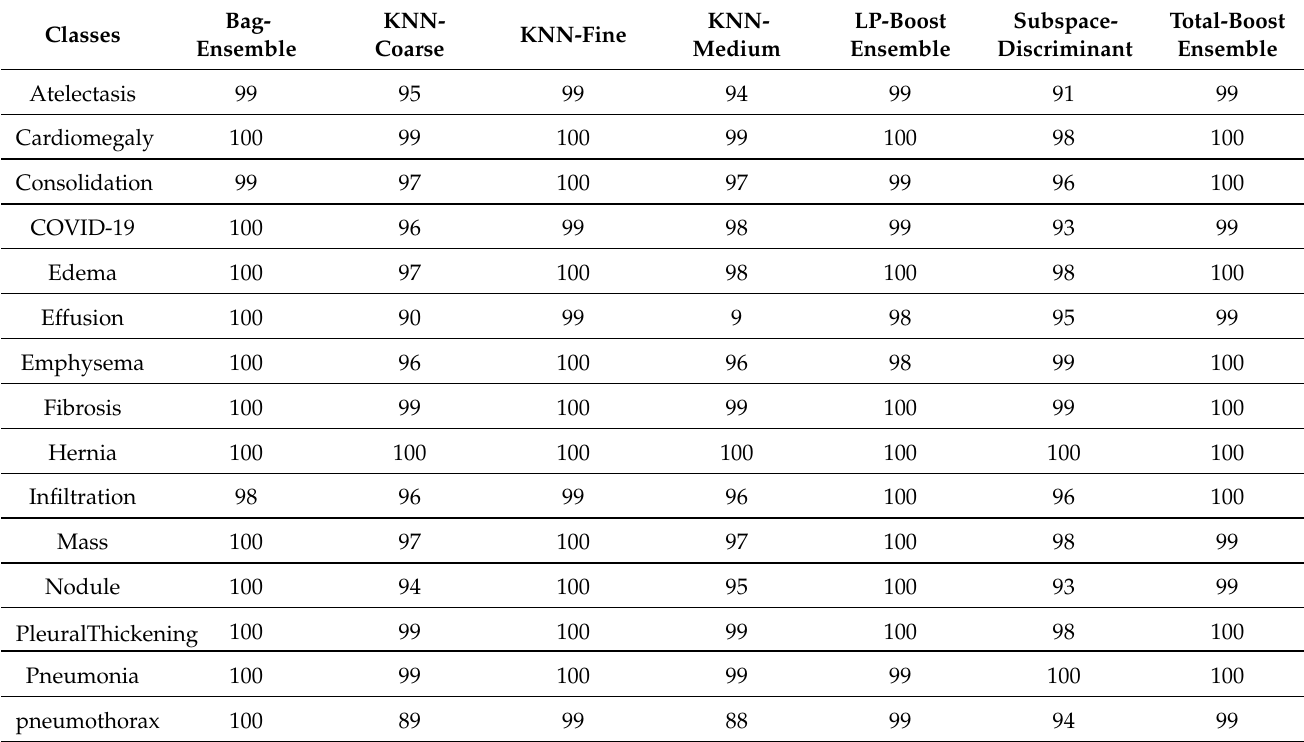
Table 9. Self-activated features based on classification using the ten-fold technique results on individual class